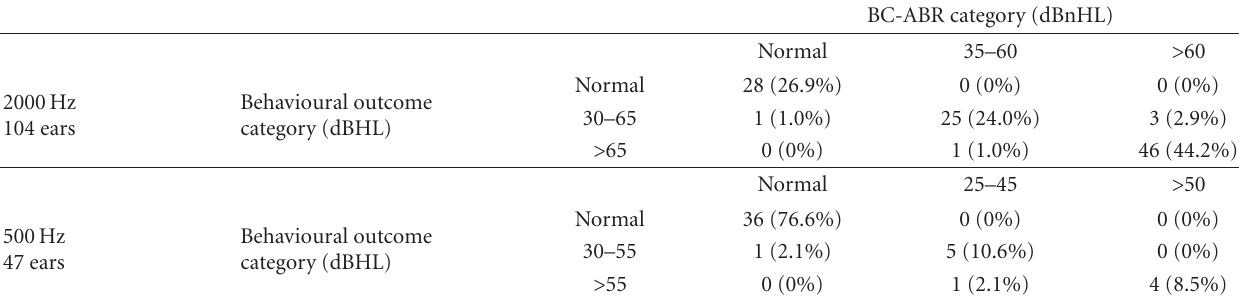
Table 2: Comparison of BC-ABR category to AC behavioural threshold data for 2000 Hz and 500 Hz.